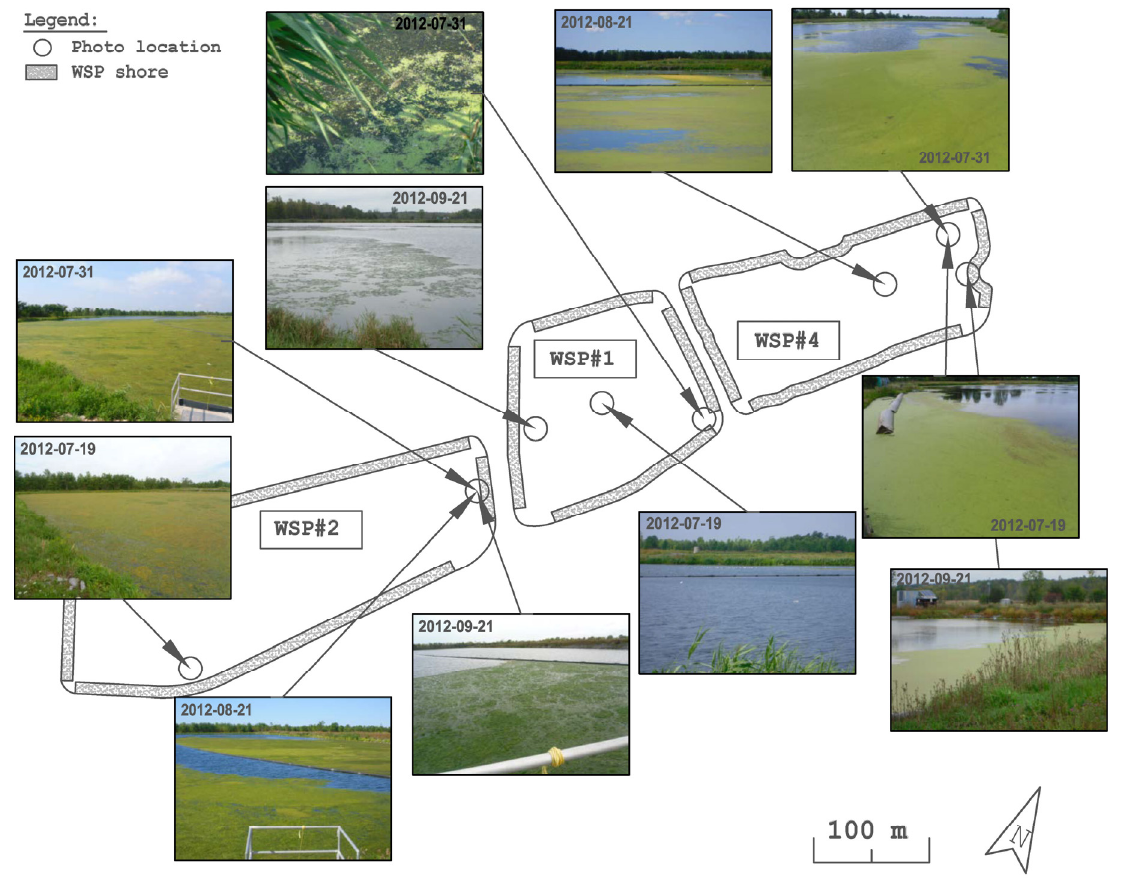
Figure 2. Site photographs taken throughout the sampling period for each WSP over a range of dates in the July to September 2012 sampling period at the Amherstview WPCP, with photograph locations